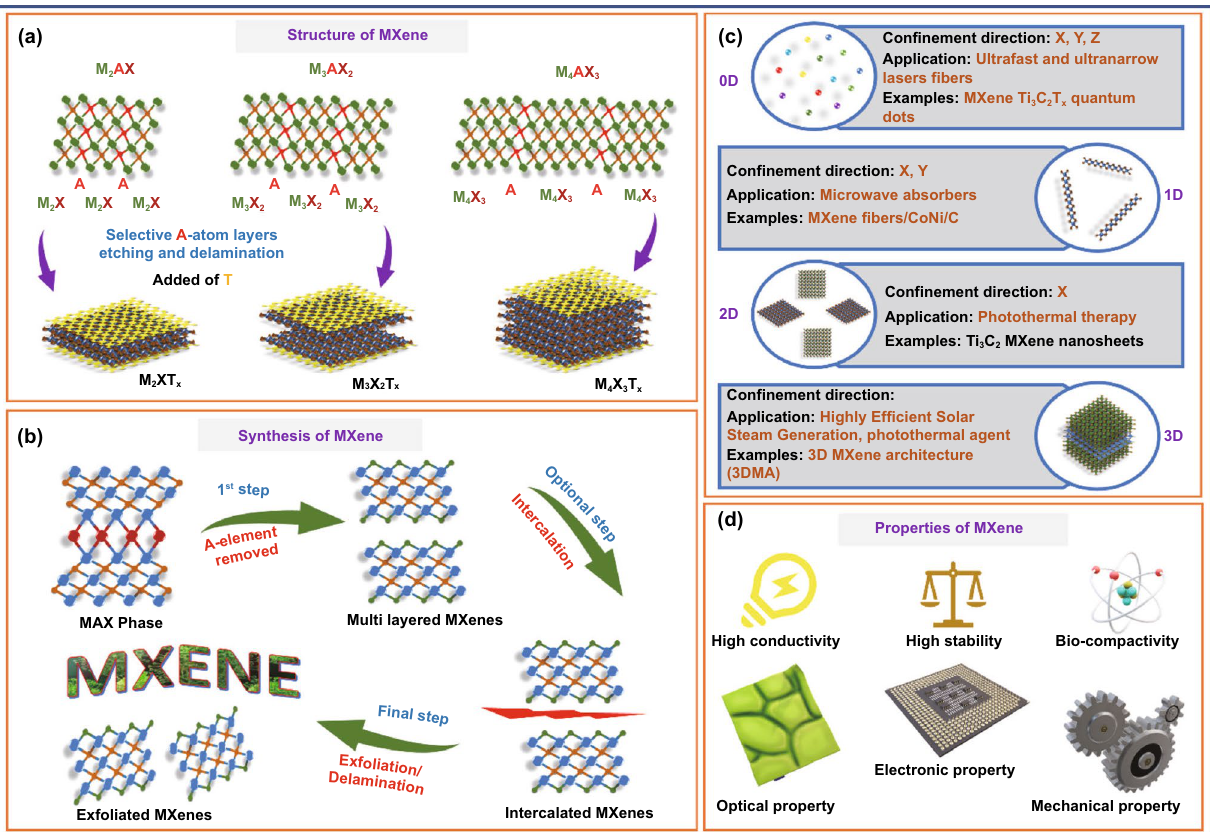
Fig. 4 a Structure of MXene. b Synthesis of MXene. c Dimensional-based classification. d Properties of